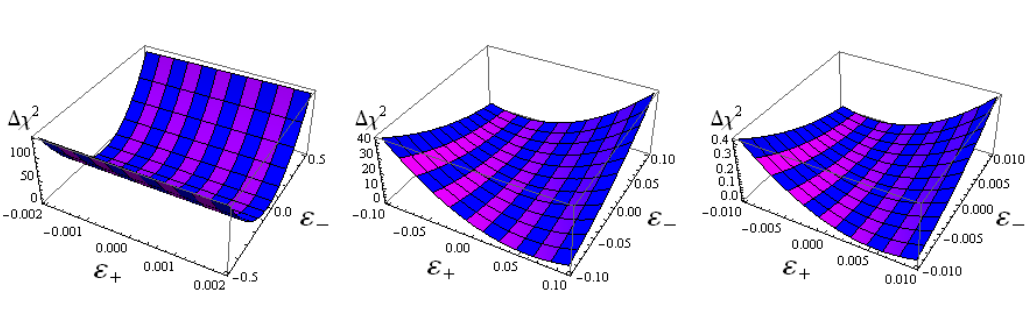
Figure 5 . Future prospects: 3-dimensional view of the correlation between source NSI parameters " + and " (cid:0) : See text for details.